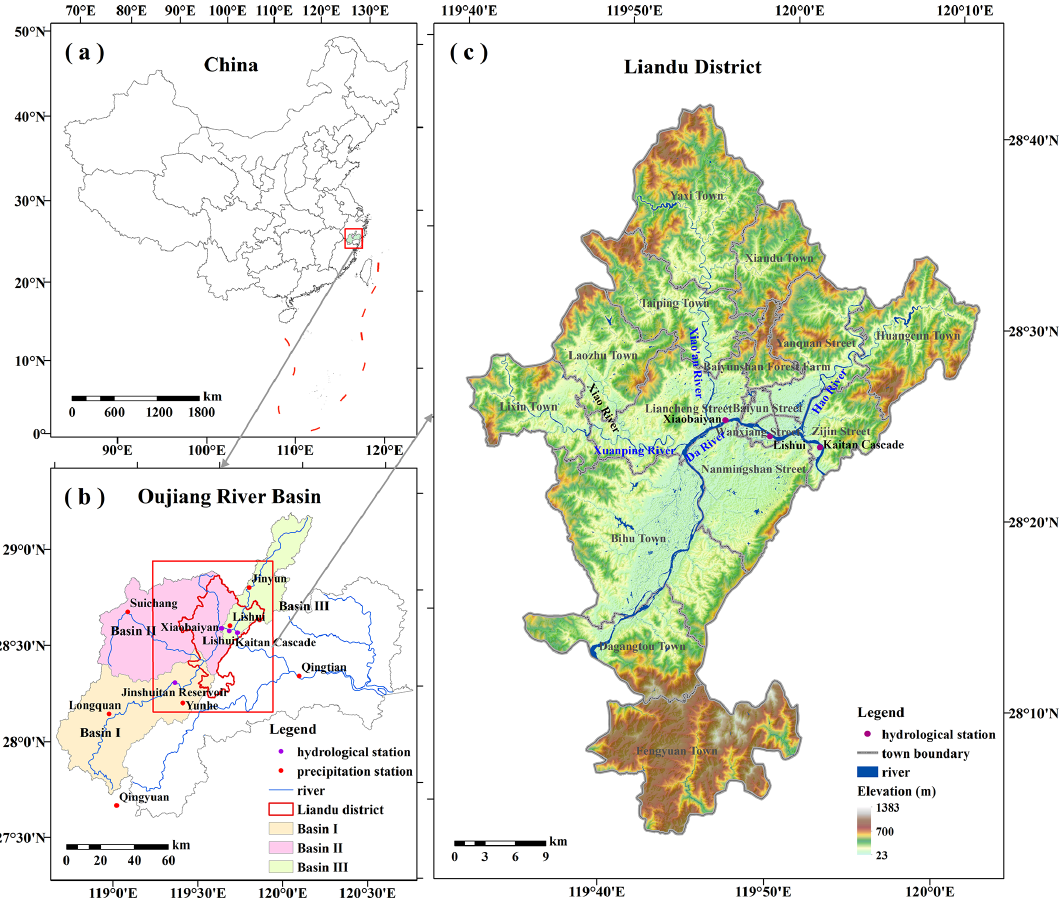
Figure 1. Location of the study area. (a) The location of Oujiang River basin in China. (b) The distribution of hydrological stations, pre- cipitation stations, rivers and sub-basins in Oujiang River basin and the location of Liandu district in Oujiang River basin. (c) The terrain distribution and town boundary of Liandu